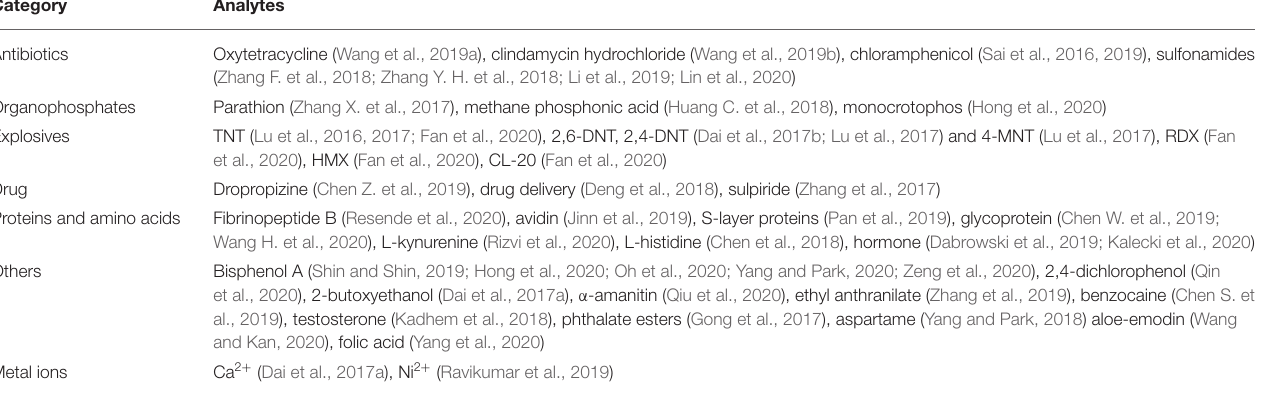
TABLE 1 | Molecularly imprinted photonomic crystals sensors and their target analytes. Category